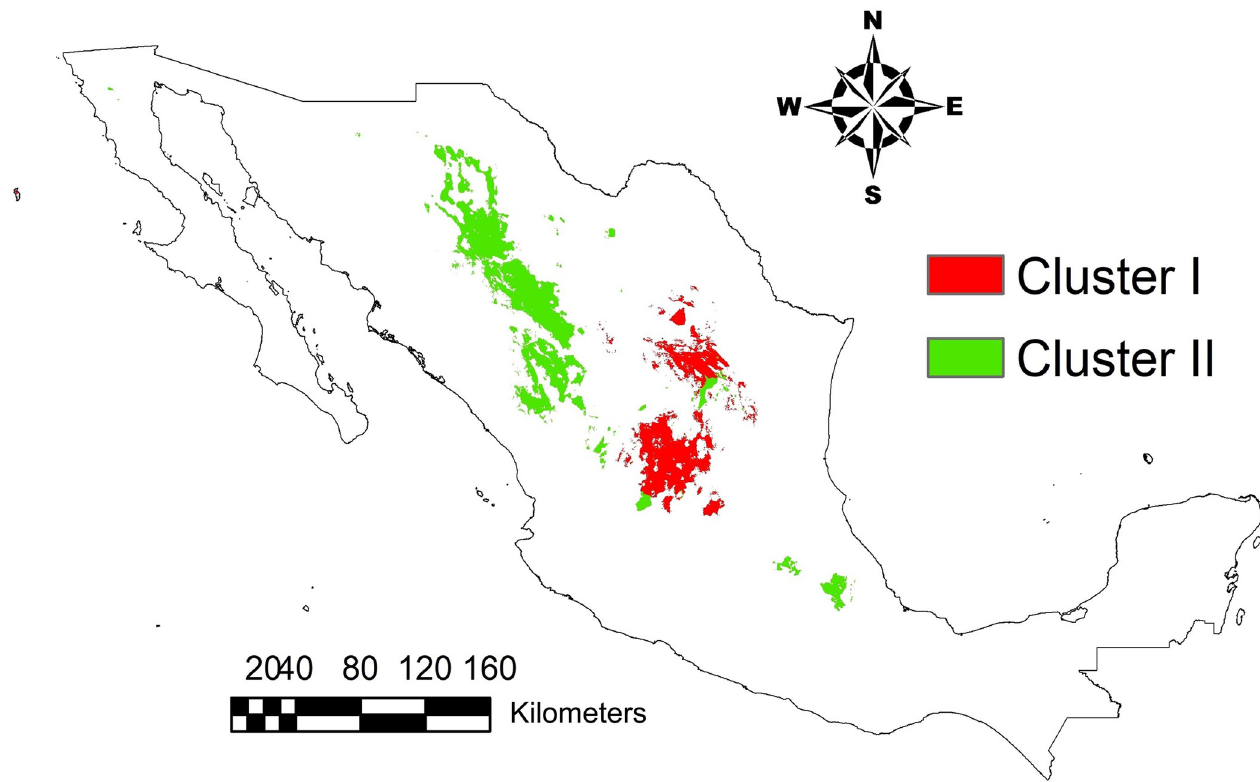
Fig 6. Areas with a probability of occurrence greater than 80% for the distribution two genetic clusters of sideoats grama ( Bouteloua curtipendula ), based on historical (1970–2000) bioclimatic variables as derived from environmental niche models in MaxEnt.